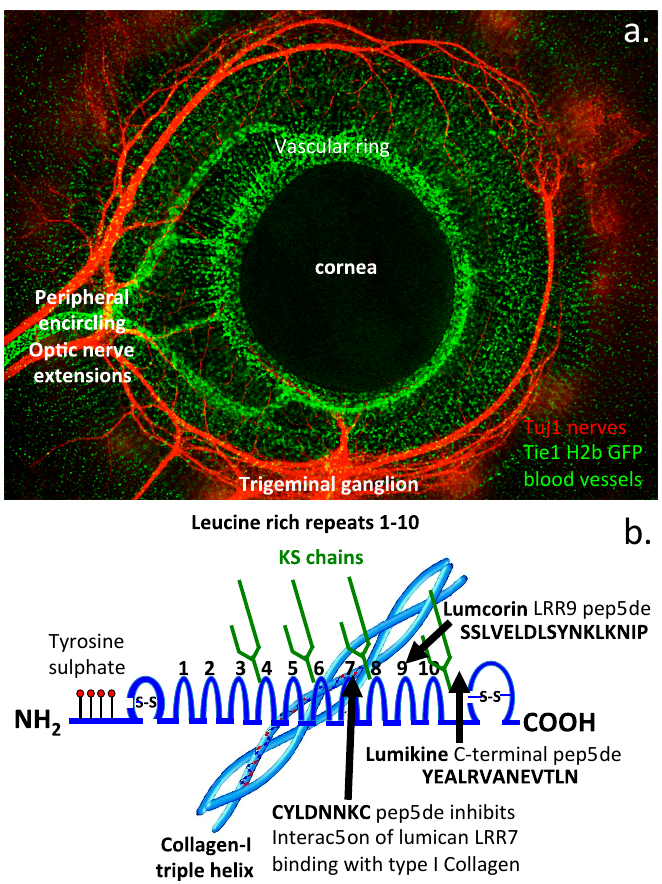
Figure 7. Composite figure depicting the distribution of nerves and blood vessels around the cornea in an embryonic quail and illustration of the structural organization of lumican which contributes to its functional properties in tissues. A fluorescent image depicts the developmental peripheral trigeminal nerve and associated blood vessels regulated by keratocan and lumican in the E7 quail eye. The trigeminal nerve was visualized using a Tuj-1 antibody. Ocular blood vessels were visualized using green fluorescent protein labeled TG–Tie-1H2b under the direction of the endothelial orphan receptor Tie-1 and plasminogen receptor histone 2B promoters. Image kindly supplied by Associate Prof Peter Ligwale, Rice University, USA ( a ). Diagrammatic depiction of lumicans structure and the leucine rich repeat 7 mediated interaction of lumican with type I collagen which regulates collagen fibrillogenesis ( b ). The synthetic peptide CYLDNNKC inhibits this interaction between lumican LRR7 and type-I collagen. A peptide, lumcorin from LRR9 also has α 2 β 1 integrin binding and cell regulatory properties. Lumikine a C-terminal lumican peptide also binds ALK5 / TGF β R1 and has wound healing